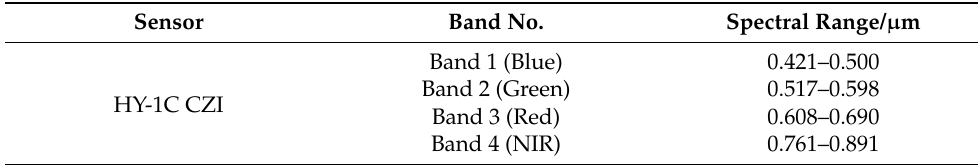
Table 1. Band information of HY-1C/D CZI.